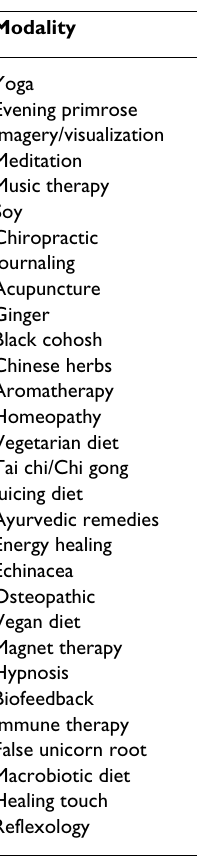
Herbal medicine Music therapy